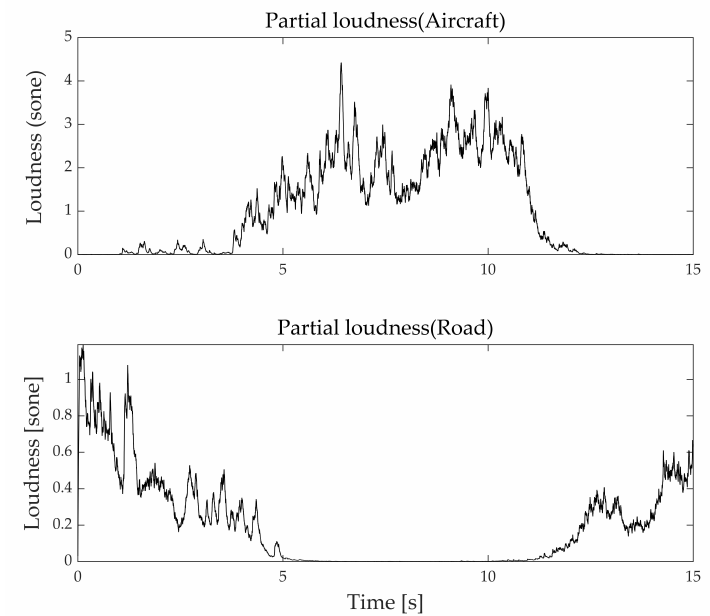
Figure 15. Partial loudness in combined